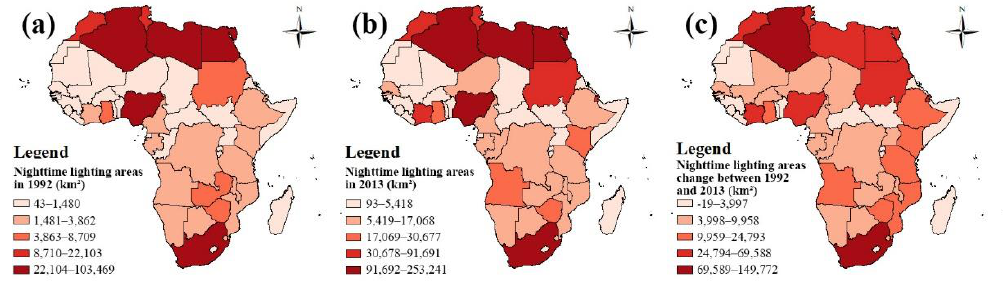
Figure 7. Nighttime lighting areas: ( a ) in 1992; ( b ) in 2013; ( c ) change between 1992 and 2013. Table 3. Statistics of NLA in major countries from 1992 to 2013.